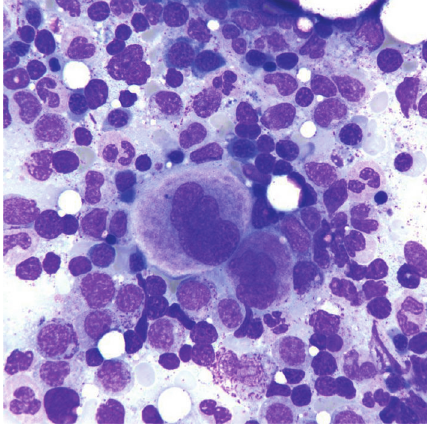
Figure 3: Bone marrow aspirate with normal megakaryocytes (Wright-Giemsa, original magnification ×